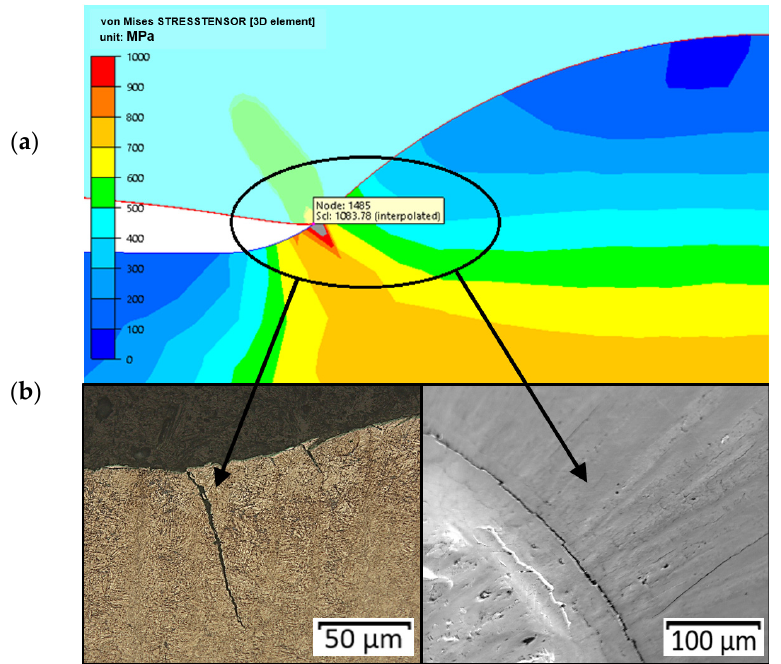
Figure 19. A crack localized in the area of stress concentration on the circumference of the calotte: ( a ) results of numerical simulations (top—The forging’s disk, bottom—The punch’s calotte), ( b ) SEM and a microstructure image.